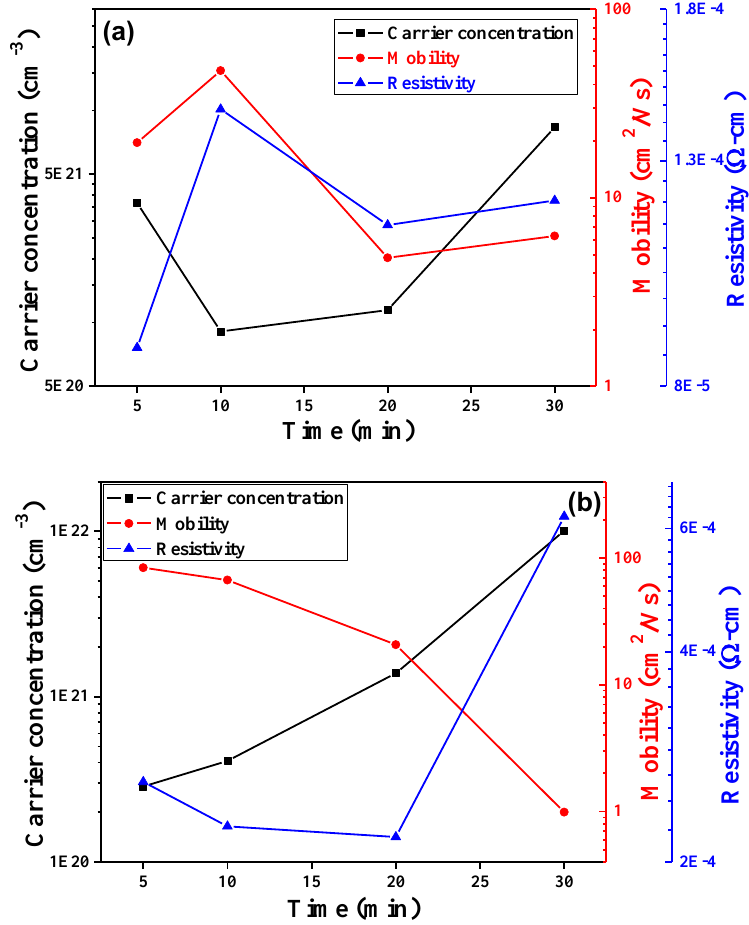
Figure 9. Carrier concentration ( n ), hall mobility ( μ ), and resistivity ( ρ ) of the CIS absorber layers as a function of annealing time, with using solution volume was ( a ) 0.05 mL; and ( b ) 0.1 mL,